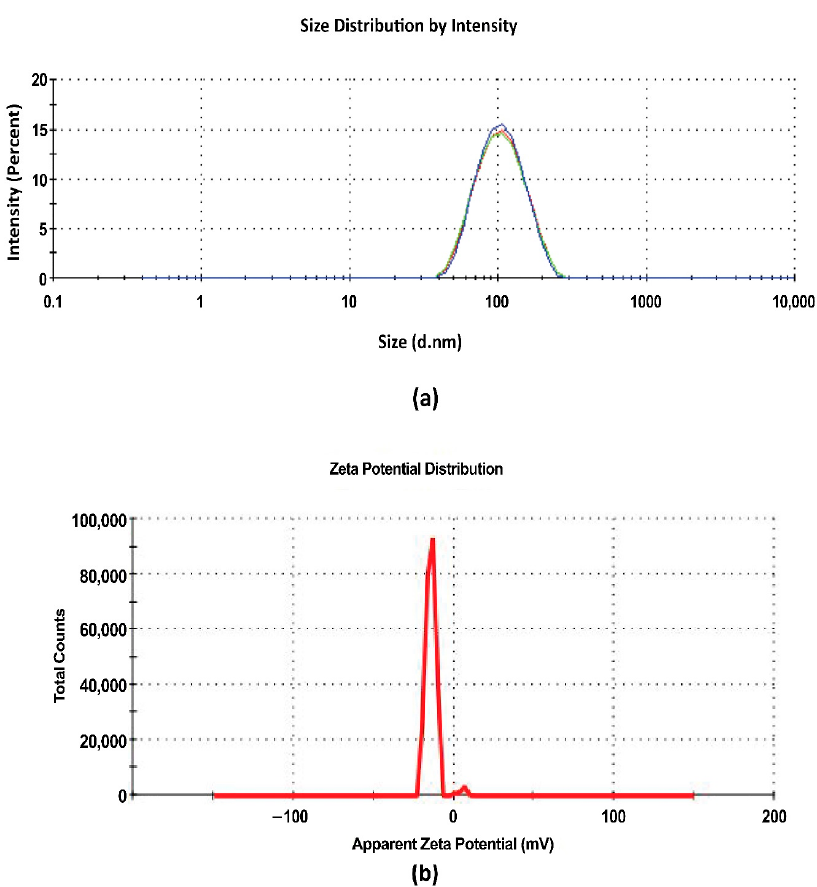
Figure 4. Graphical representation of ( a ) droplet size and ( b ) zeta potential of TAM-RES-s- SNEDDS.